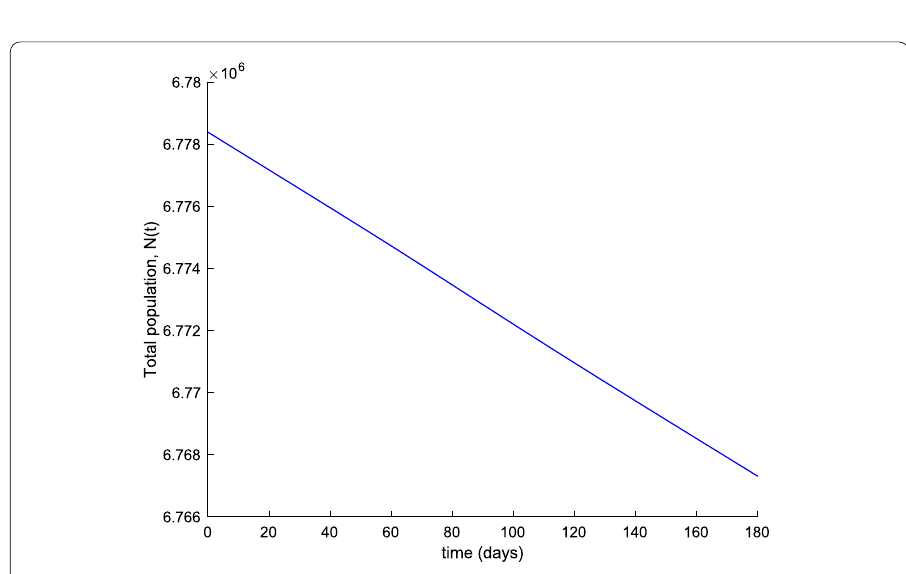
Figure 14 Evolution of the total population when vaccination and treatment are applied with k V = 0.001 and k T =